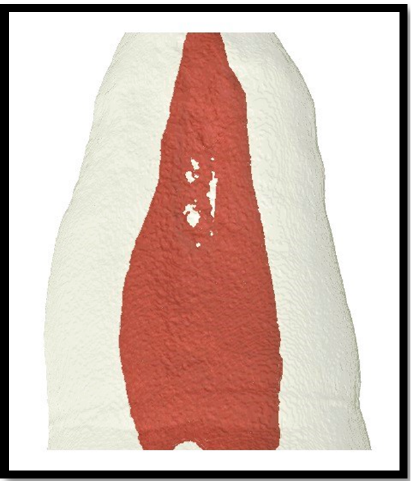
Figure 13. Micro-CT image showing the middle third location of the accessory canal.